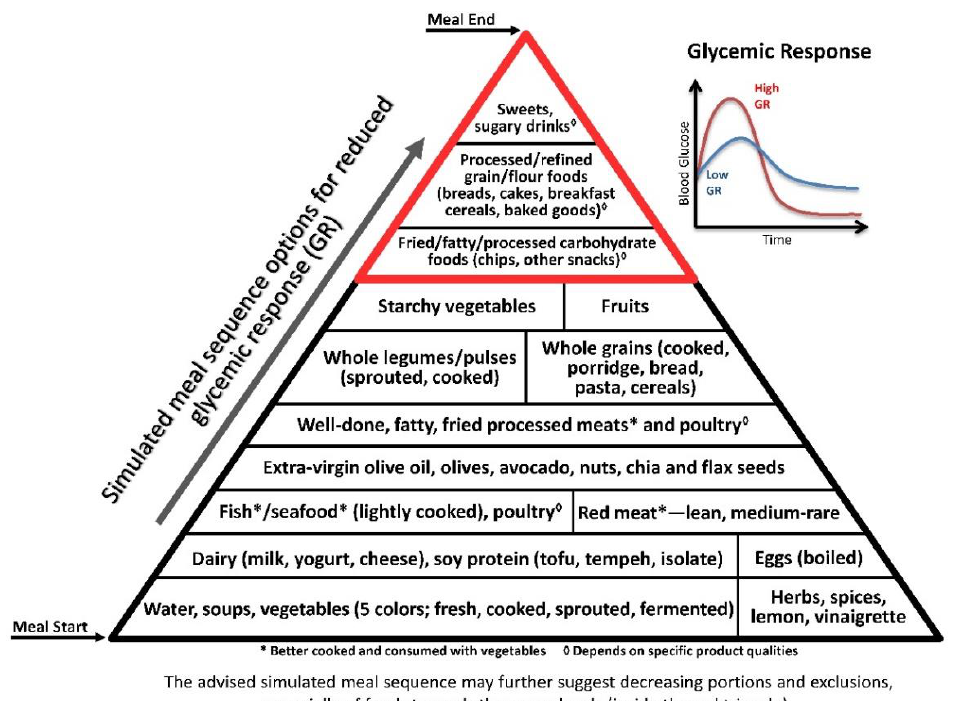
Figure 2. Figure 2. The Meal Sequence Pyramid per Glycaemic Response (GR) Axis. This pyramid